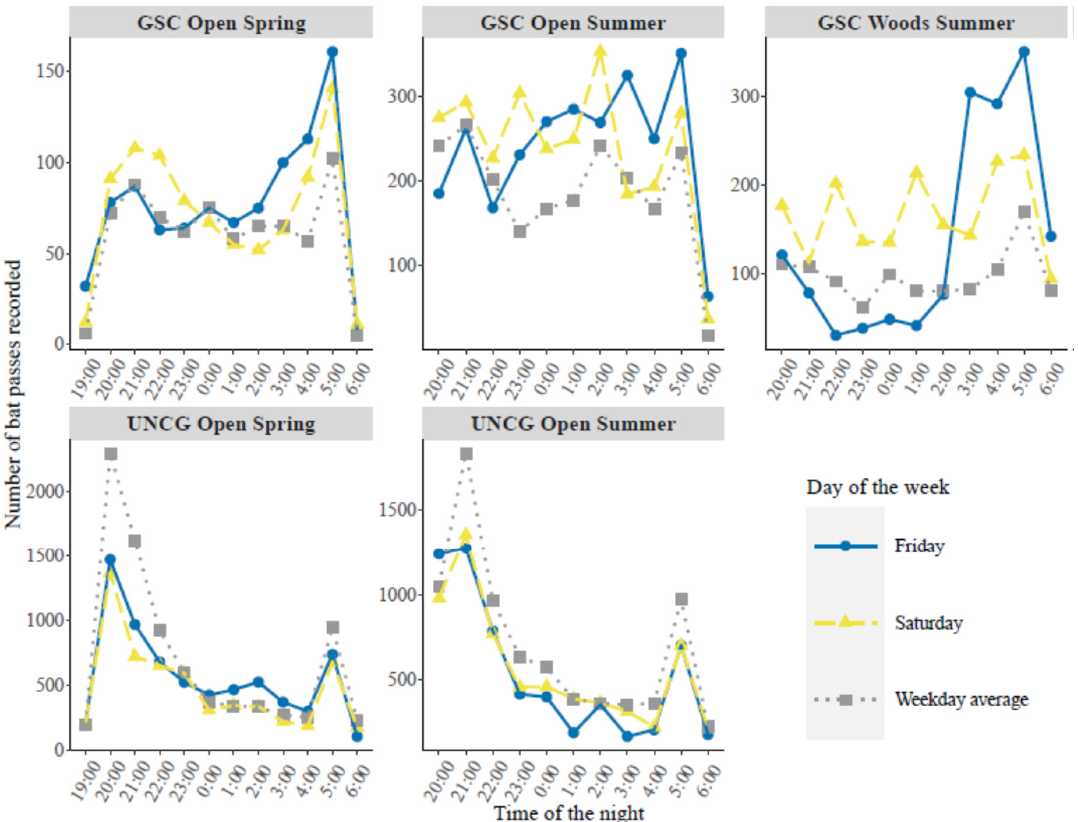
Figure 3. Hourly total bat activity plot to compare Friday, Saturday, and weekday average for sites and season where total bat activity was different on weekends from weekdays in Greensboro, North Carolina, USA. University of North Carolina Greensboro (UNCG); Greensboro Science Center (GSC). Similarly, at the GSC woods site total bat activity was significantly higher on Friday and Saturday nights in summer (Friday regression estimate 0.929 ± 0.230, p < 0.001, Saturday regression estimate 0.869 ± 0.231, p < 0.001, Table 1). In summer we recorded 135% more bat passes on Friday